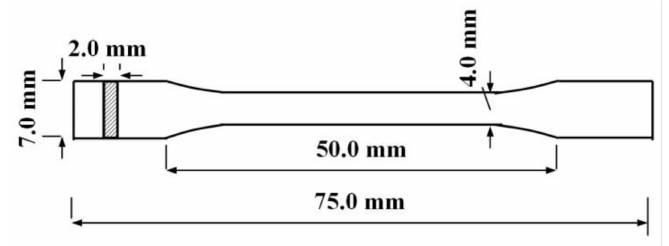
Figure 1. Stretching spline size